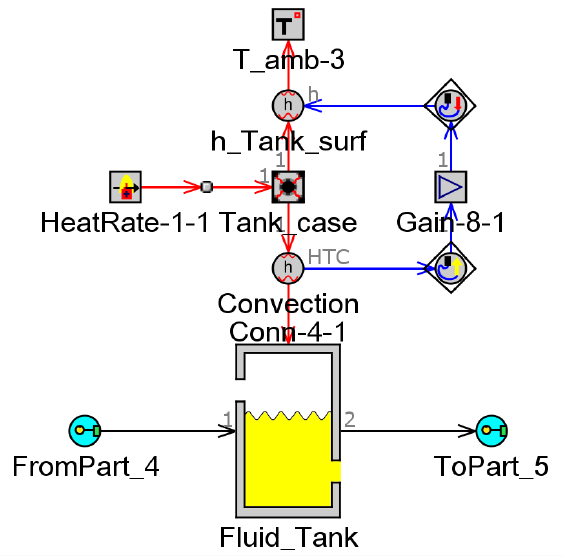
Figure 3. Induction heater modeling